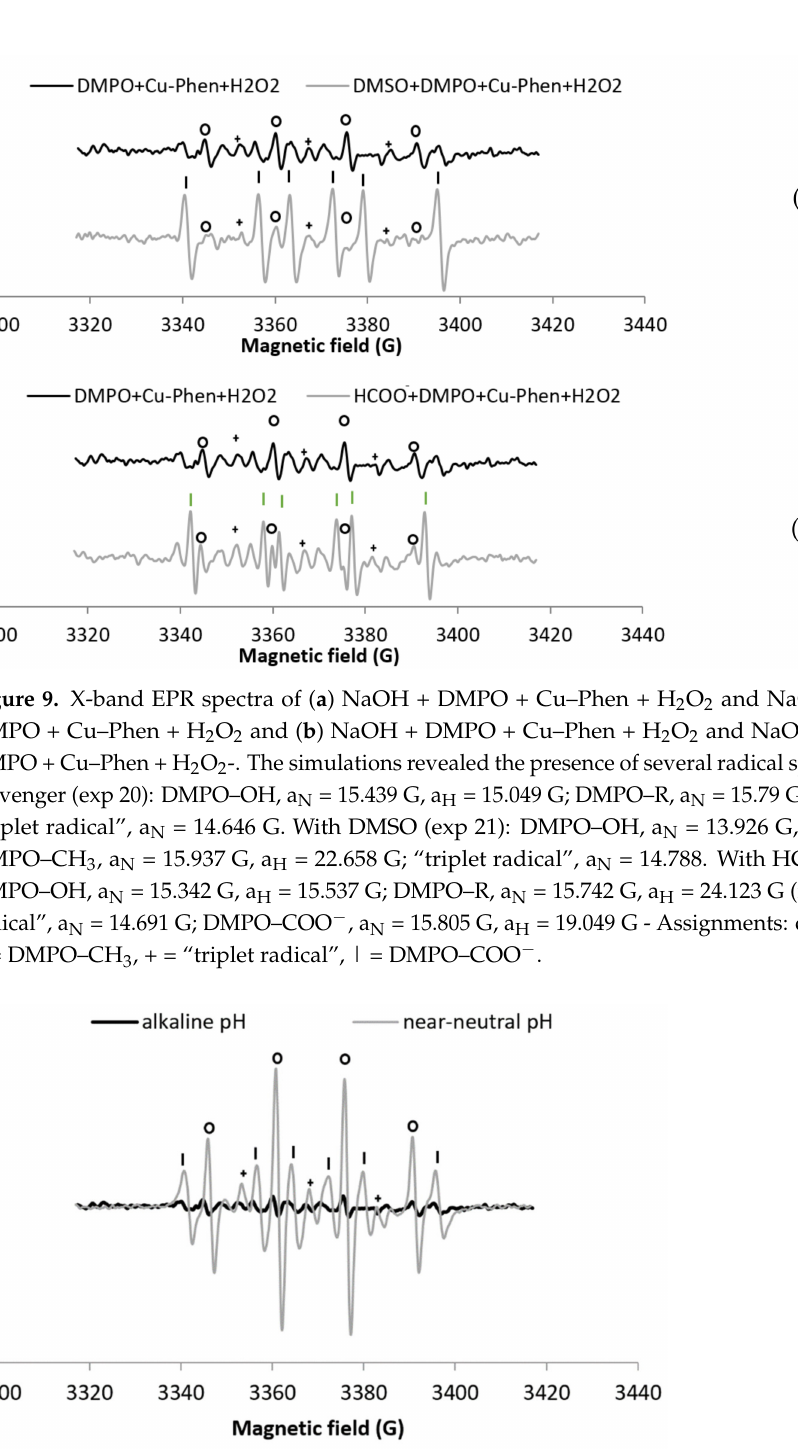
Figure 10. X-band EPR spectra of NaOH + DMPO + Cu–Phen + H 2 O 2 (exp 20) and DMPO + Cu–Phen + H 2 O 2 (exp 3). Comparison between alkaline and near-neutral pH - Assignments: o = DMPO–OH, | = DMPO–R, + = “triplet